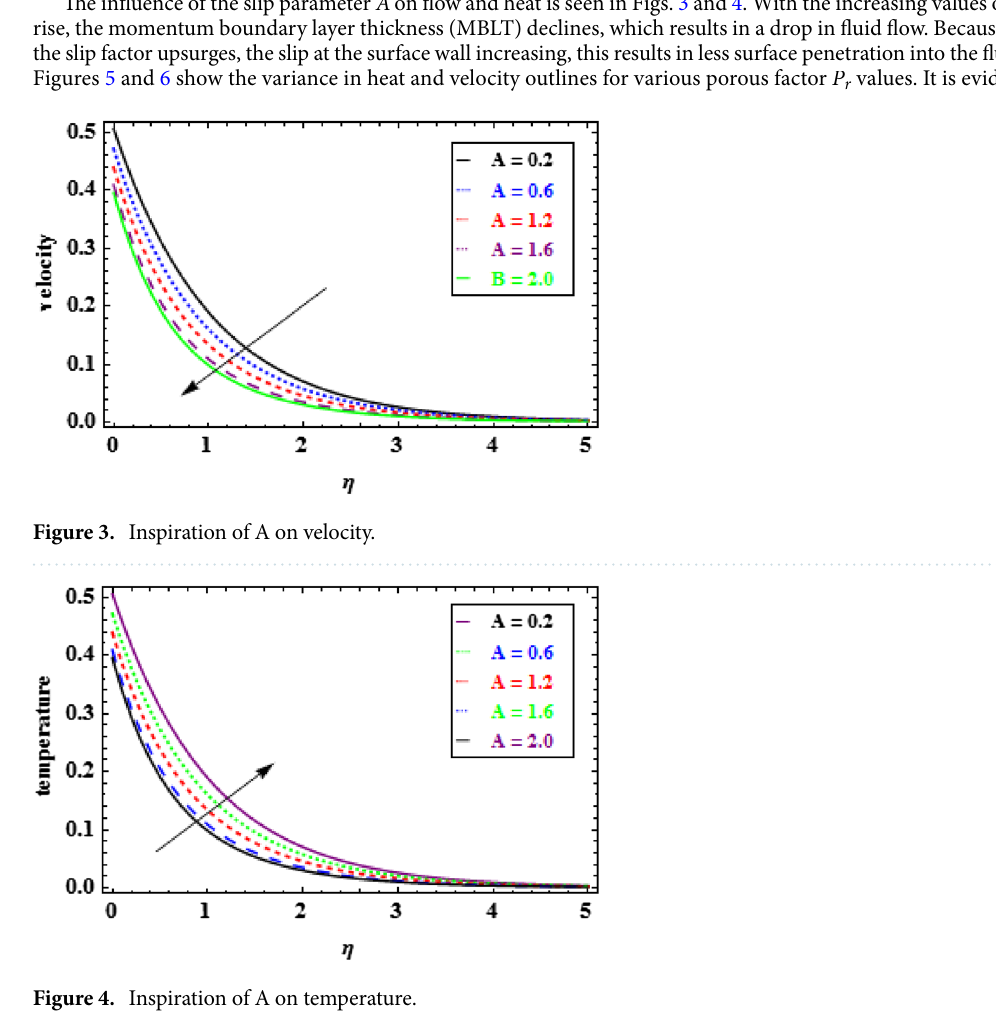
Figure 4. Inspiration of A on